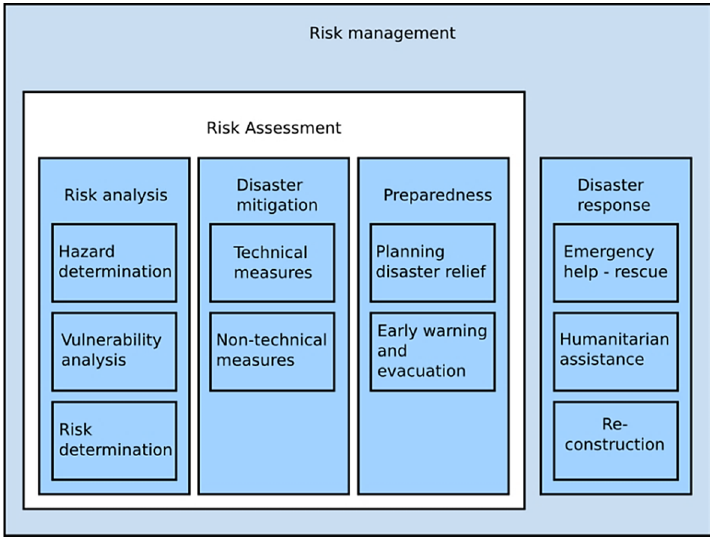
Figure 2. Elements of operational (flood) risk management, adapted from Plate